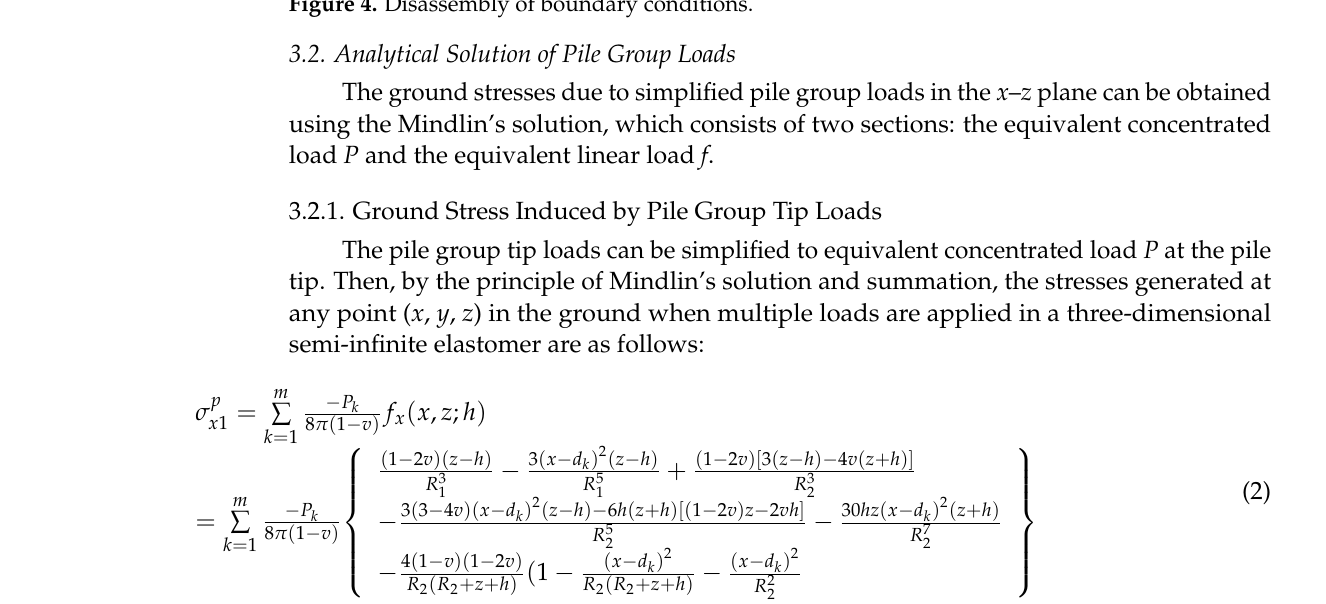
Figure 4. Disassembly of boundary conditions.